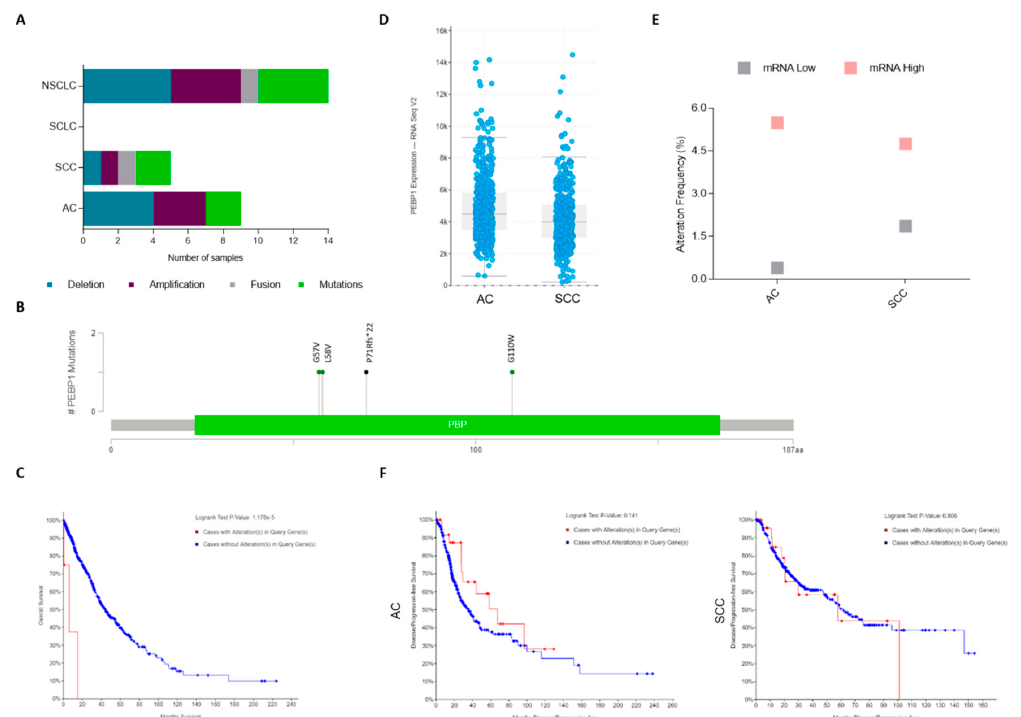
Figure 2. Lung cancer The Cancer Genome Atlas (TCGA) data for genomic alterations on the RKIP encoding gene ( PEBP1 ). ( a ) Number of cases depicting RKIP genomic alterations in the different